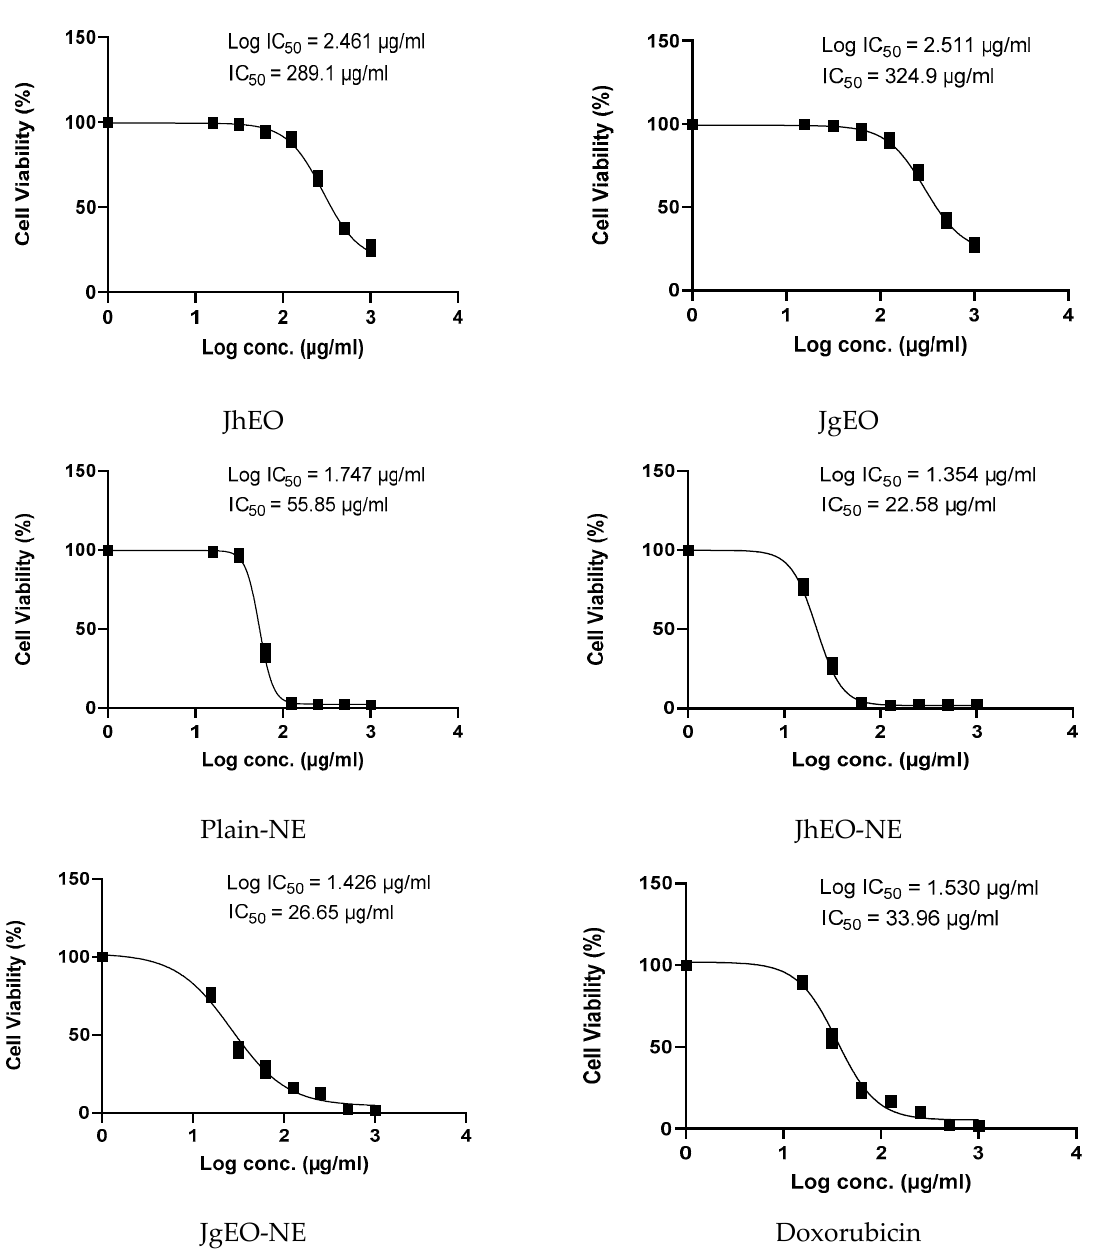
Figure 2. IC 50 of J. humile (JhEO) and J. grandiflorum (JgEO) pure essential oils, their nanoemulsion formulations (JhEO-NE) and (JgEO-NE), plain nanoemulsion formulation (Plain-NE) as well as standard doxorubicin against HepG-2 cell line.